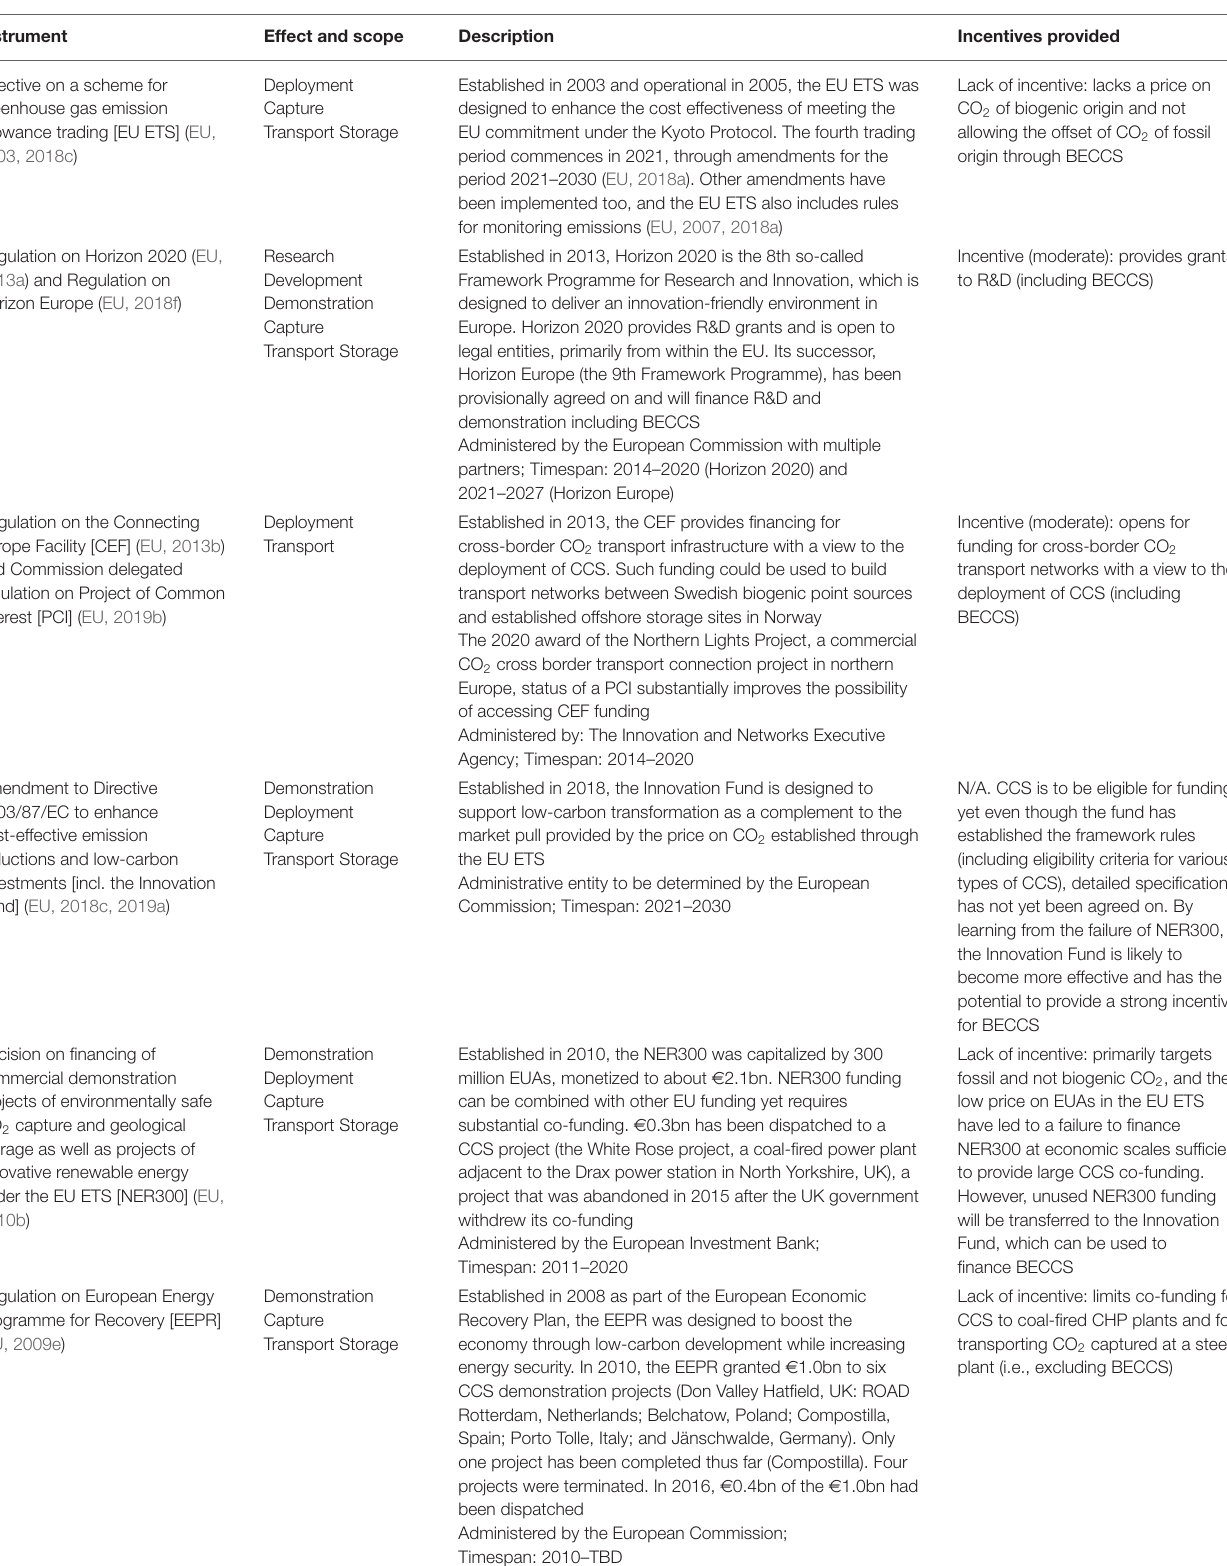
TABLE 4 | Supranational (EU) economic policy instruments of direct relevance to BECCS RDD&D in Sweden, in descending order of